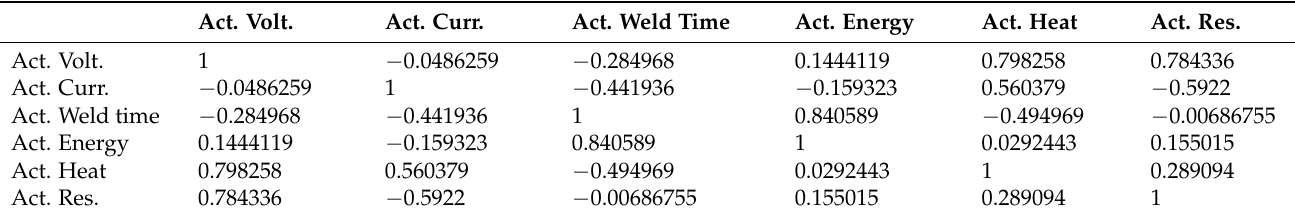
Figure 8. Wear–expulsion relationship. Table 7. Correlation matrix for actual features.